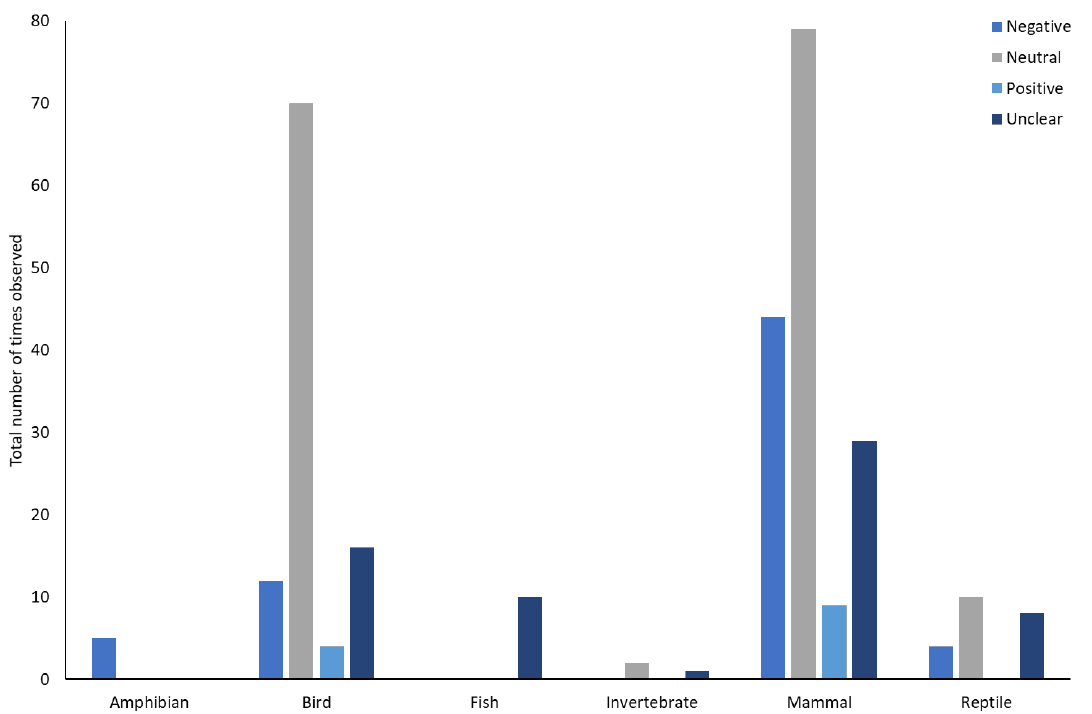
Figure 7. An overview of the number of times different responses were reported to zoo visitors across the taxa. Table 2. An overview of response to visitors as a function of animal order. The most frequent be- haviour response is highlighted in bold for each animal-based measure.